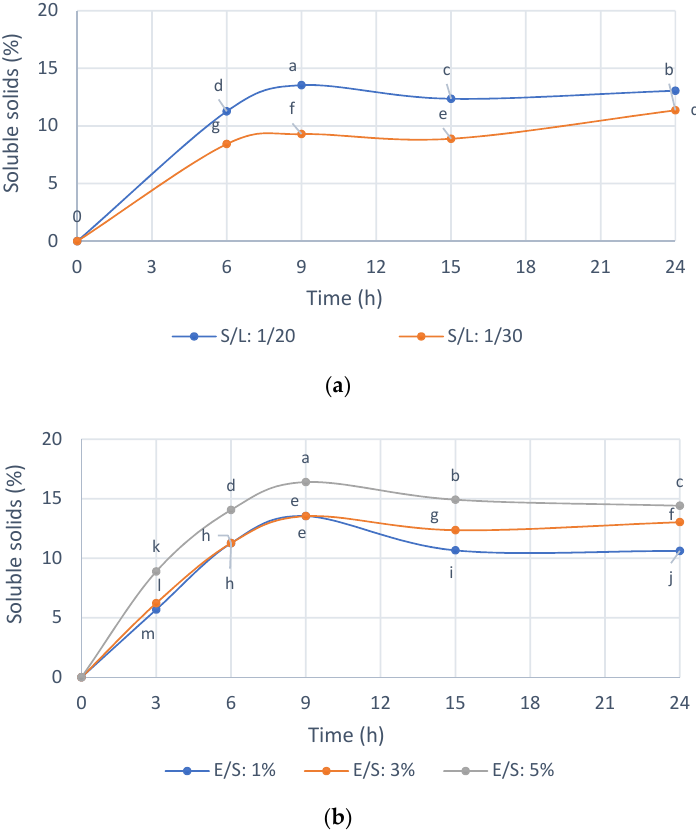
Figure 4. ( a ) Effect of Solid/Liquid ratio on the soluble solids with Endogalacturonase (50 °C, pH 4, E/S 3%). ( b ) Effect of enzyme/substrate ratio on the soluble solids with Endogalacturonase (50 °C, pH 4, S/L 1/20). E/S = wet weight of enzyme preparation/dry weight of solid of the substrate. Mean ± SD ( n = 4). The median that does not share a letter are significantly different ( p > 0.05), comparing all values together with ANOVA and Tukey’s test.